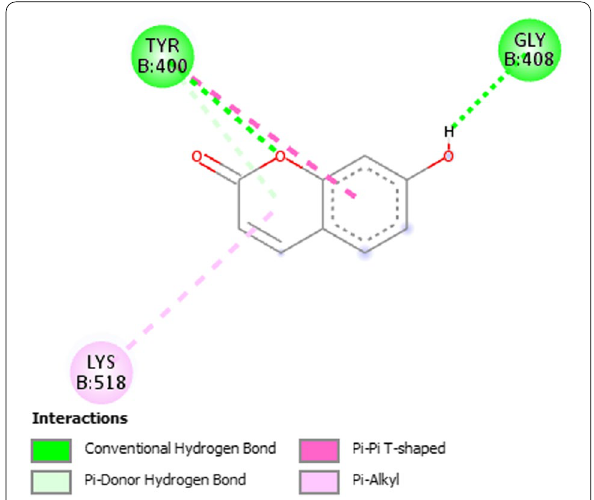
Fig. 10 2D interaction of compound 1 with crystal structure of S . aureus (PDB: